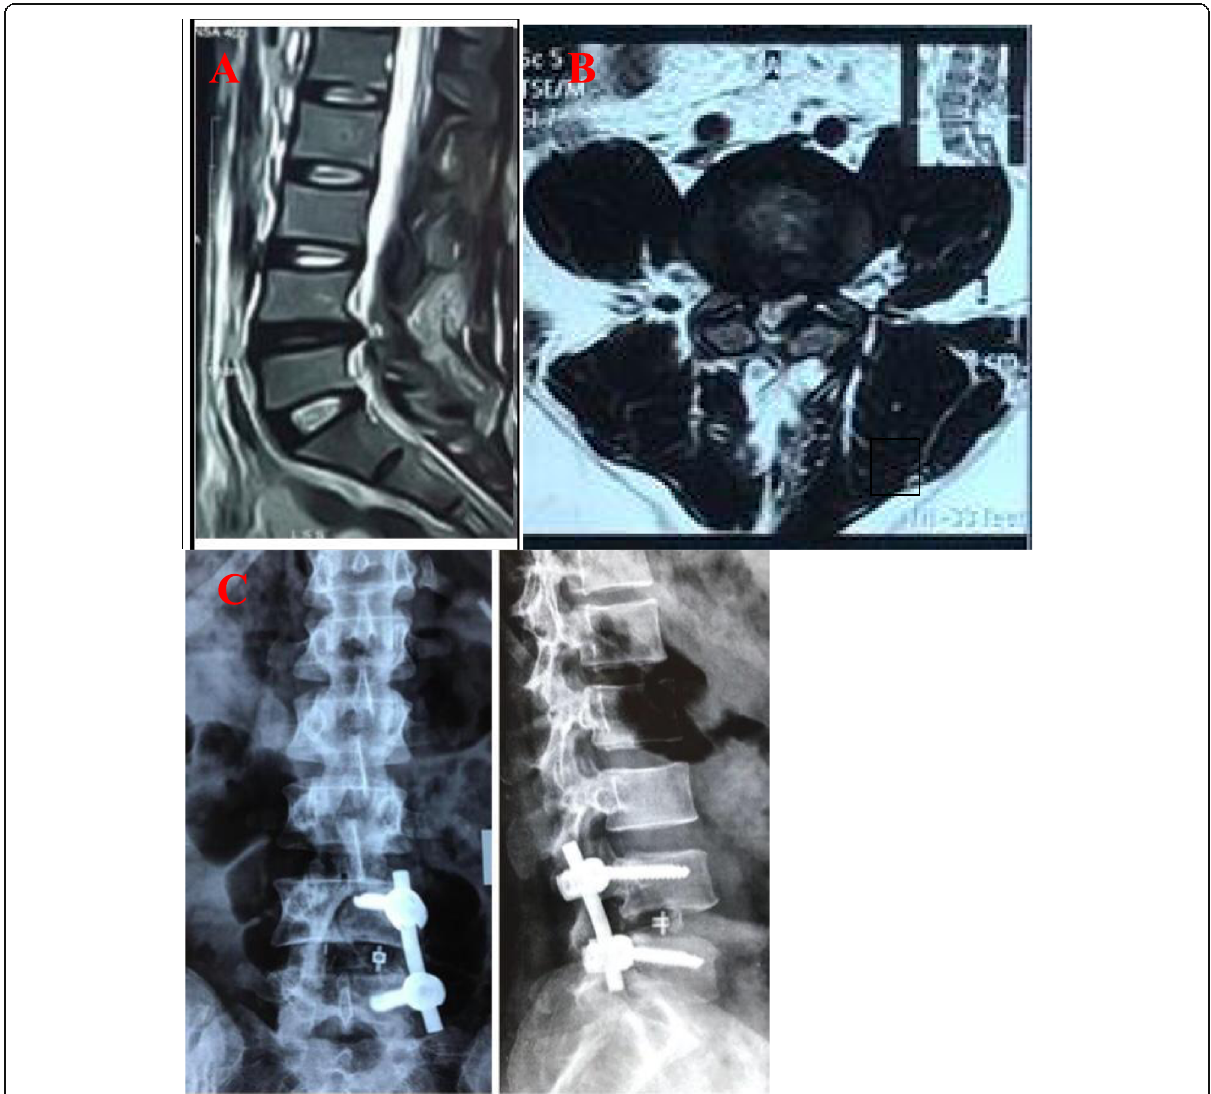
Fig. 1 Images of 40-year-old female patient with recurrent L4 – 5 disc prolapse presented with LBP and Right sciatica. Preoperative MRI lumbosacral spine. a Sagittal T2-weighted image and b axial T2WI showing recurrent LDP of L4 – 5 level. c Postoperative 12 months follow up plain x-ray lumbosacral spine AP view and lateral view with unilateral transpedicular screw fixation at L4 –